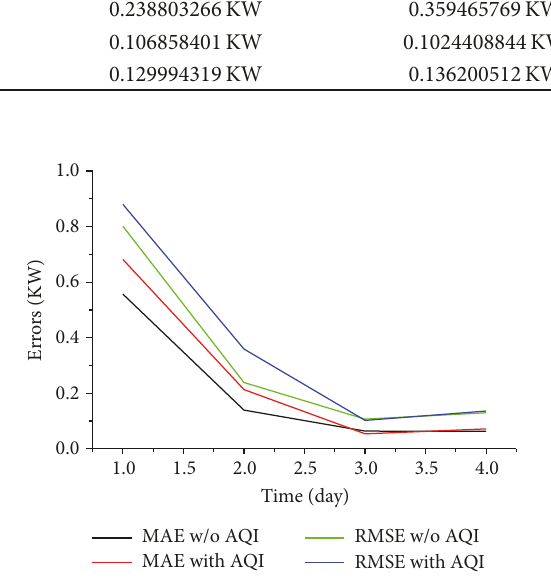
Figure 8: Errors during clear